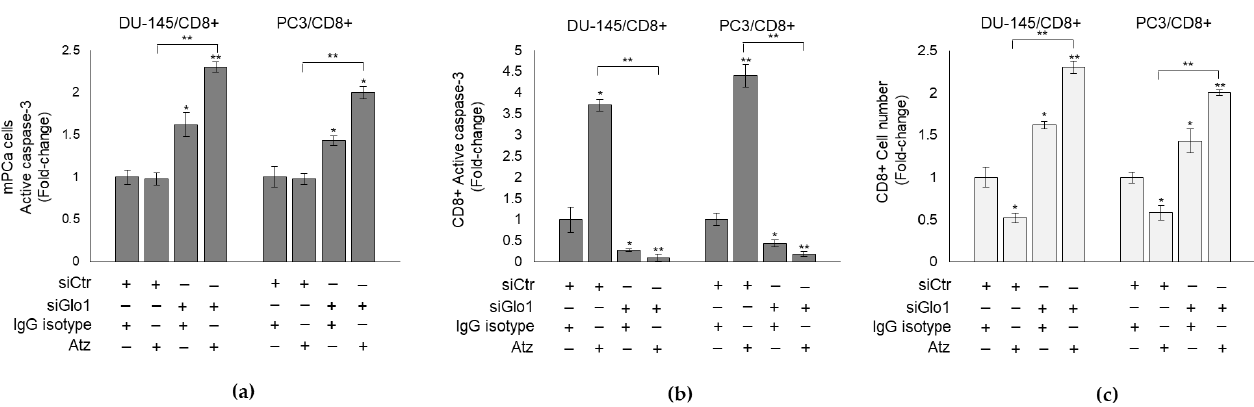
Figure 8. Targeting Glo1 induces atezolizumab (Atz) response in mPCa cells. siGlo1-silenced DU145 and PC3 or controls (siCtr) cells were co-cultured with CD8+ cytotoxic T cells and exposed to 10 µg/mL Atz or control IgG isotype. ( a ) mPCa cells apoptosis or ( b ) CD8+ apoptosis was evaluated by active caspase-3 expression, with a specific ELISA kit; ( c ) CD8+ cell number was measured by cell counting. The histograms indicate mean ± SD of three different cultures, and each was tested in duplicate. * p < 0.05, ** p < 0.01.